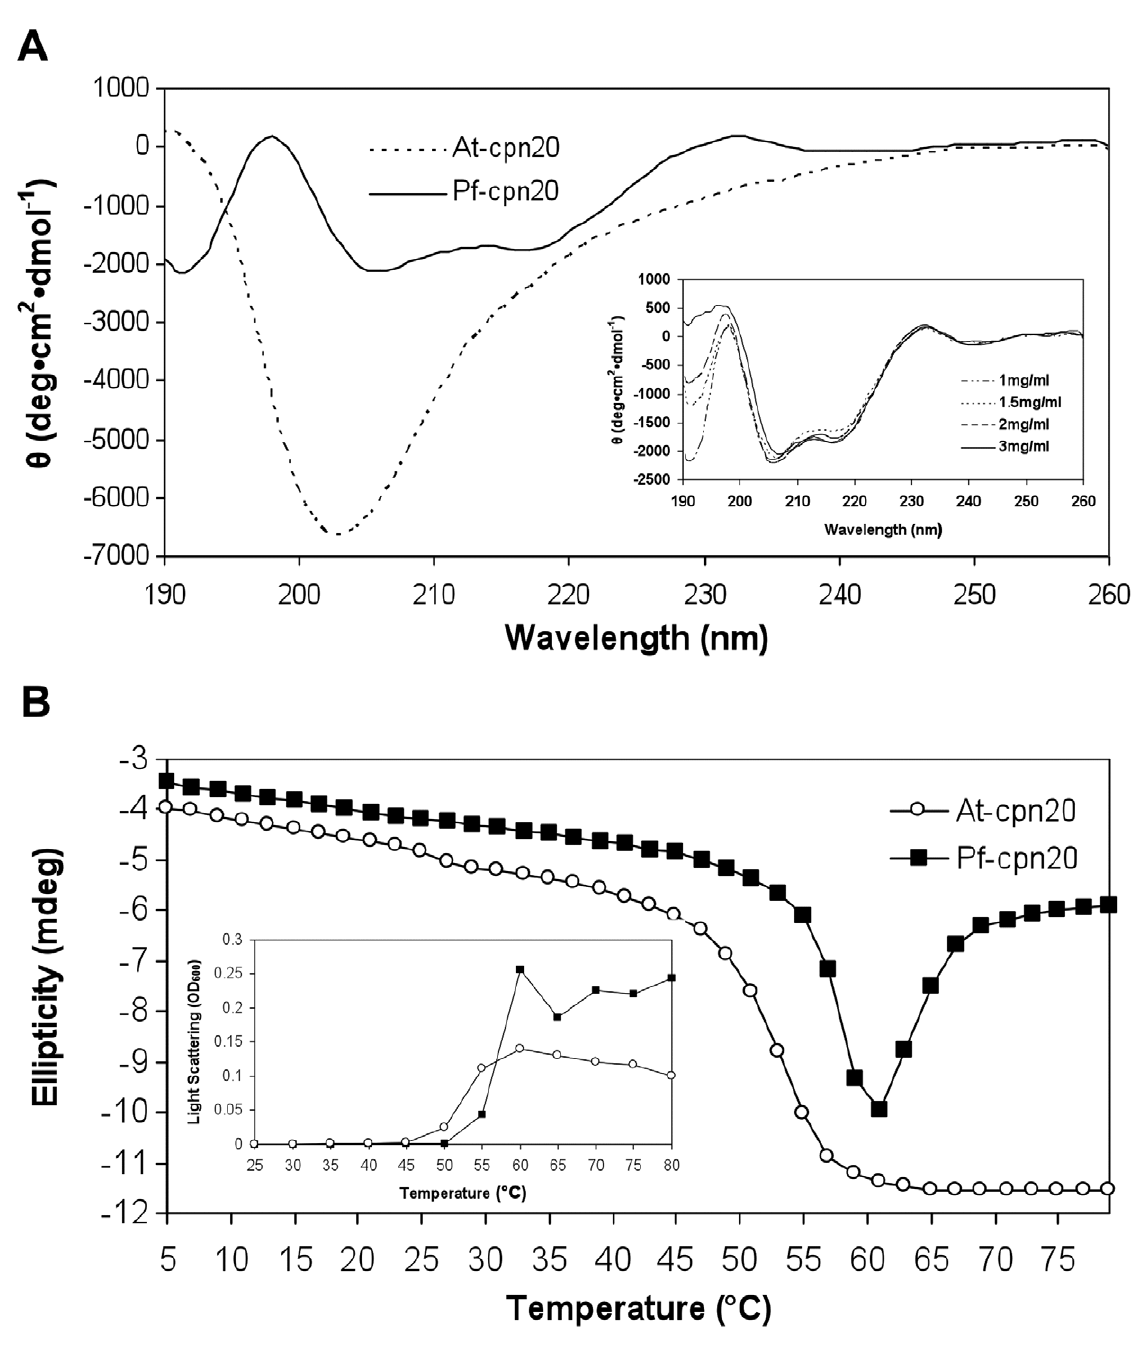
Figure 1. A circular dichroism analysis of the Pf-cpn20 structure in solution. Secondary structure characteristics of Pf-cpn20 were analyzed using a Chirascan TM spectrometer as described in Materials and Methods. A) The represented spectra of Pf- and At-cpn20 were obtained by averaging 5 spectra, correcting for buffer contribution and smoothing. Molar ellipticity as a function of wavelength is presented for each protein. Inset: The CD spectrum of solutions containing 1, 1.5, 2 and 3 mg/ml Pf-cpn20. B) Thermal denaturation curves were carried out for Pf- and At-cpn20 by varying the temperature from 5 to 79 u C at 222 nm with 2 u C intervals, 180 sec setting time and 120 sec time per point. Inset: Light scattering of Pf- and At-cpn20 measured at OD 600 at increasing temperatures between 25 and 80 u C.